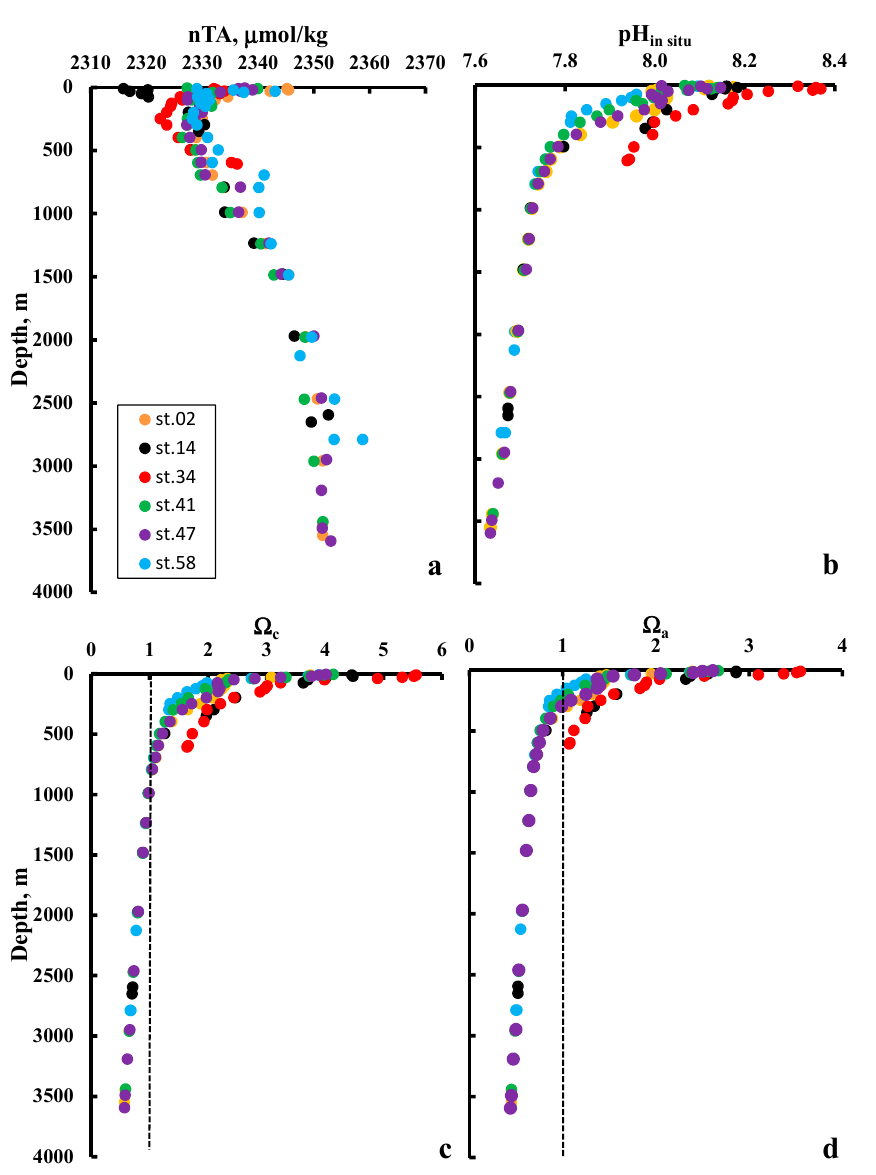
Figure 5. Vertical distributions of the carbonate system parameters for the seawater: ( a )—normalized TA (nTA = TA × 35/S); ( b )—pH in situ ; ( c )—saturation degree indices of